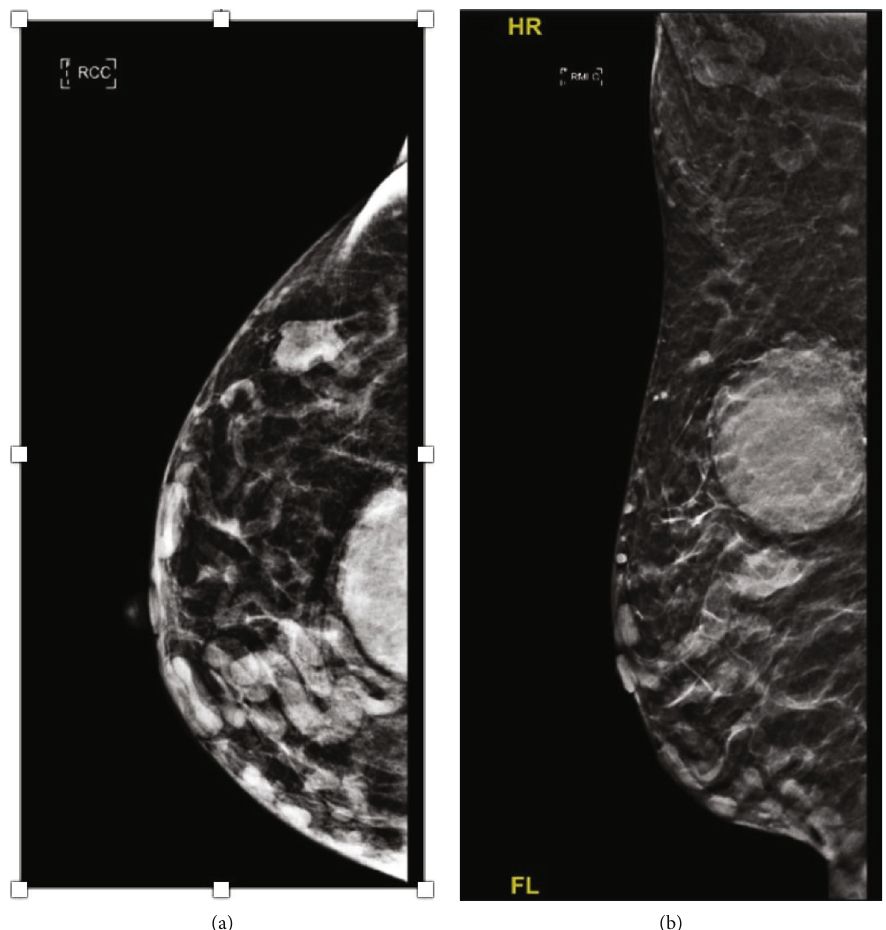
Figure 3: Mammogram of right breast showed well-circumscribed, round, high-density lesions at upper mid region and upper outer